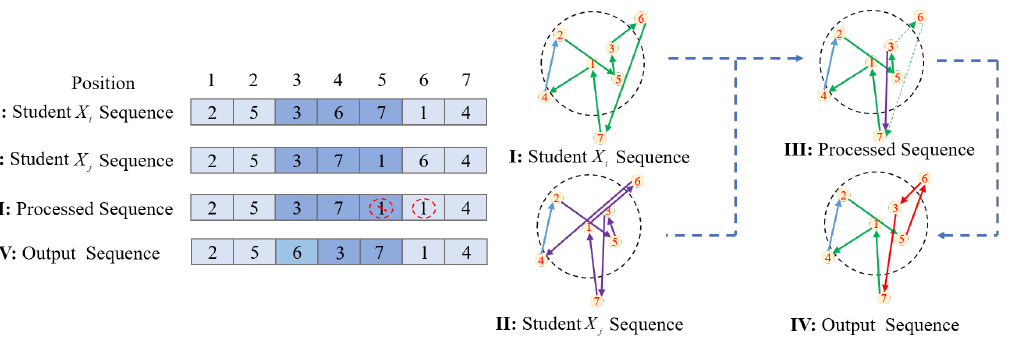
Figure 4. New greedy crossover